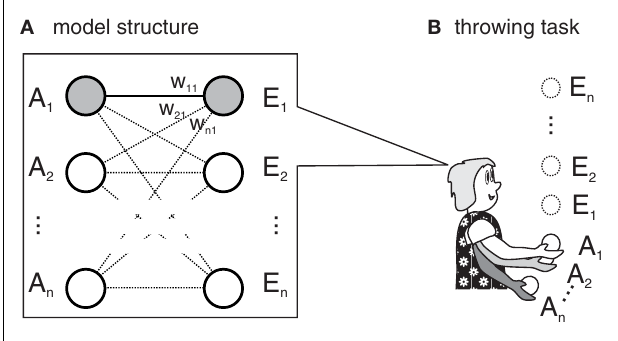
FIGURE 1 | (A) According to IdeomotorTheory, actions ( A 1 , ... ) get associated to their effects ( E 1 , ... ) when a person learns a novel task, such as throwing a ball. (B) In the example, each action node activates a throw of different strength and each effect node encodes the height of the resulting ball flight. If A 1 resulted in E 1 (gray circles), the link between both ( w 11 ) is